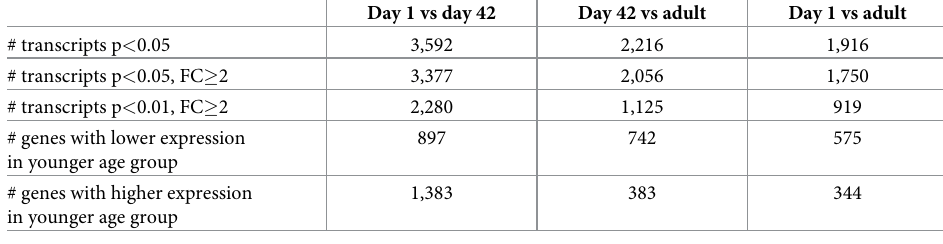
Table 1. Differential gene expression of foal and adult horse